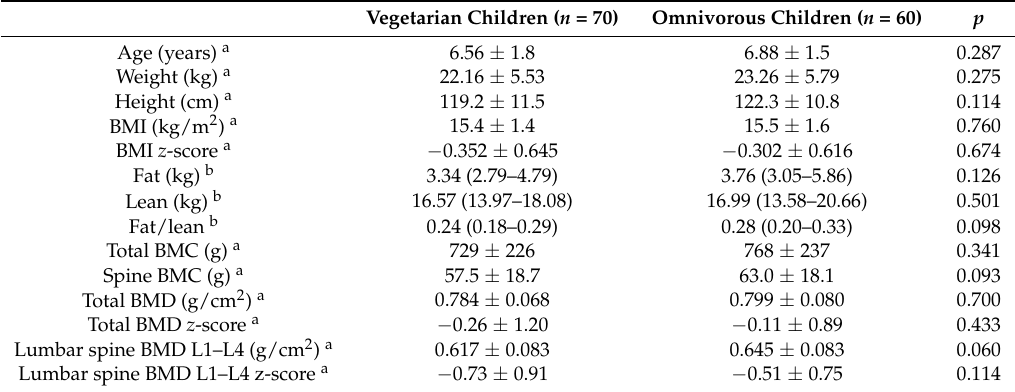
(Table 1). Mean values of body composition parameters (fat mass, lean mass, the ratio of fat/lean mass) and total and spine BMC as well and total and lumbar spine BMD were comparable in vegetarians and omnivores. Table 1. Clinical and anthropometric data in vegetarian and omnivorous